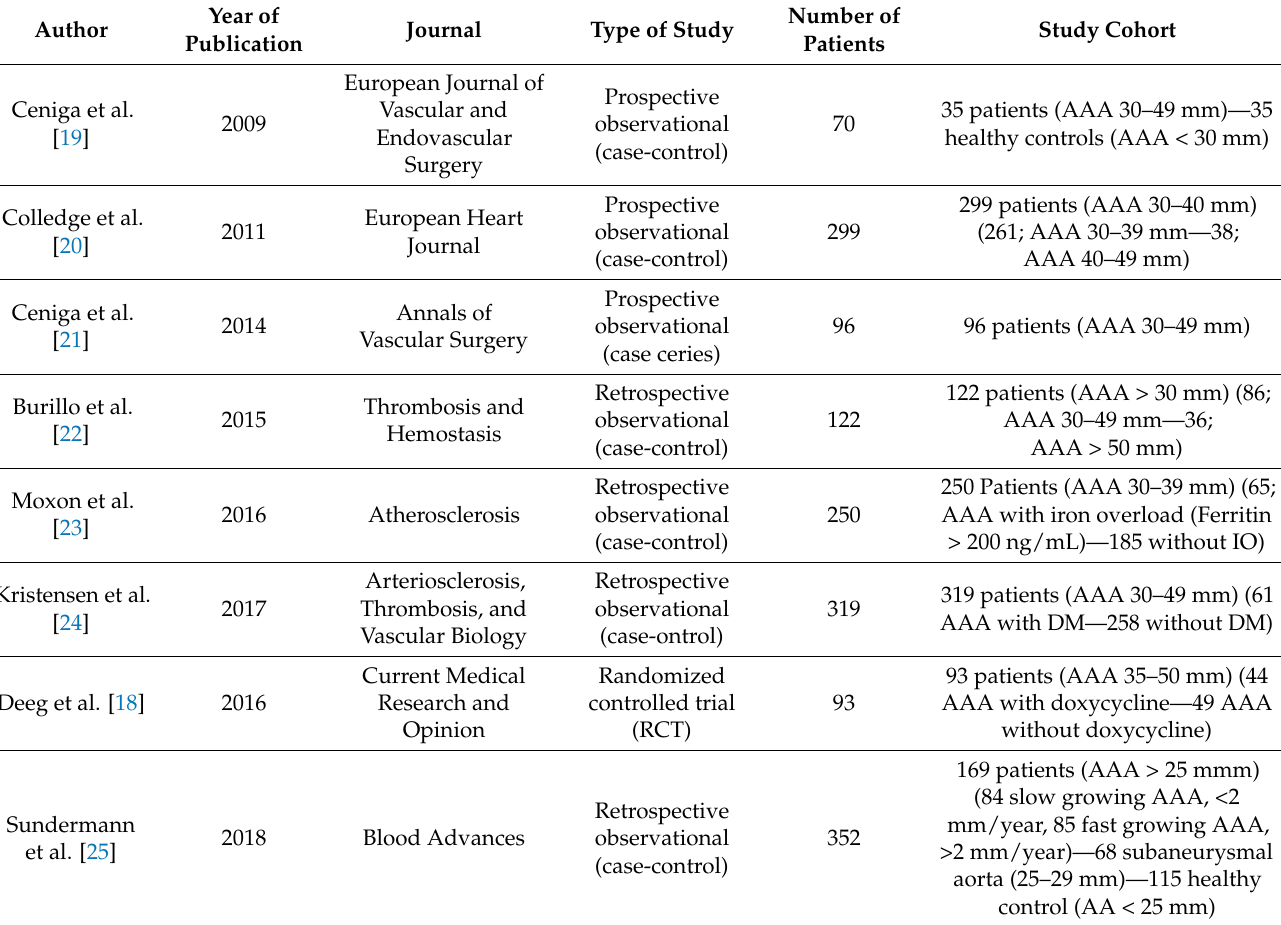
Table 1. General characteristics of studies on circulating clinical